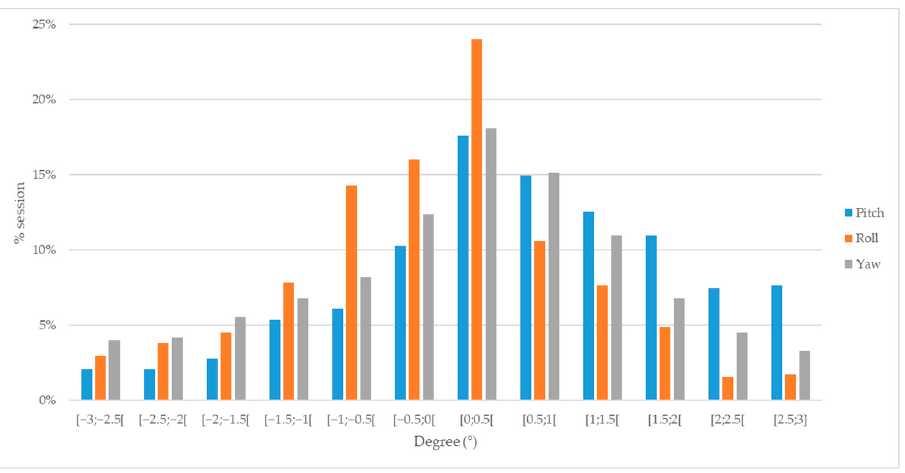
Figure 2. Histogram showing the distribution of pitch (blue), roll (orange), and yaw (grey) adjust- ments of each treatment session.